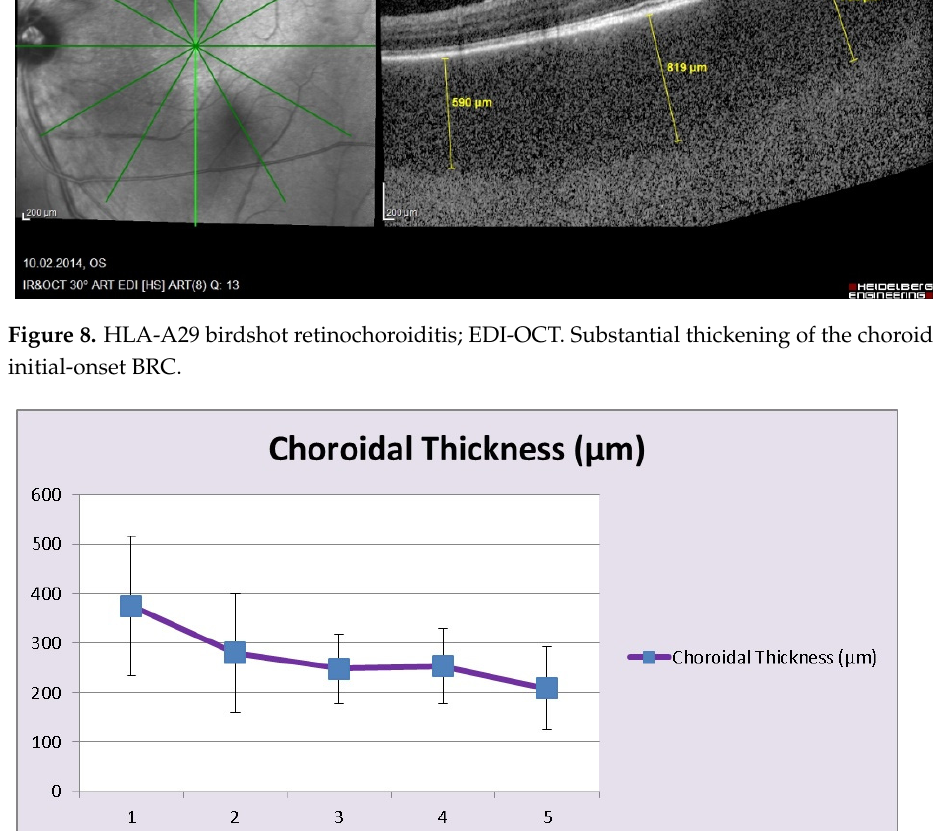
Figure 9. HLA-A29 birdshot retinochoroiditis; choroidal thickness. Over time, as disease progresses choroidal thickness is decreasing (1 = <1 year; 2 = 1–4 years, 3 = 5–9 years, 4 = 10–15 years, 5 = >15 years).